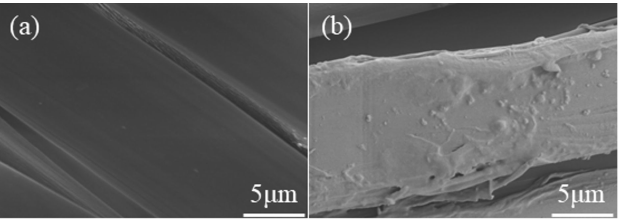
Figure 3. Scanning electron microscopy images of ( a ) control and ( b ) TLP-finished silk